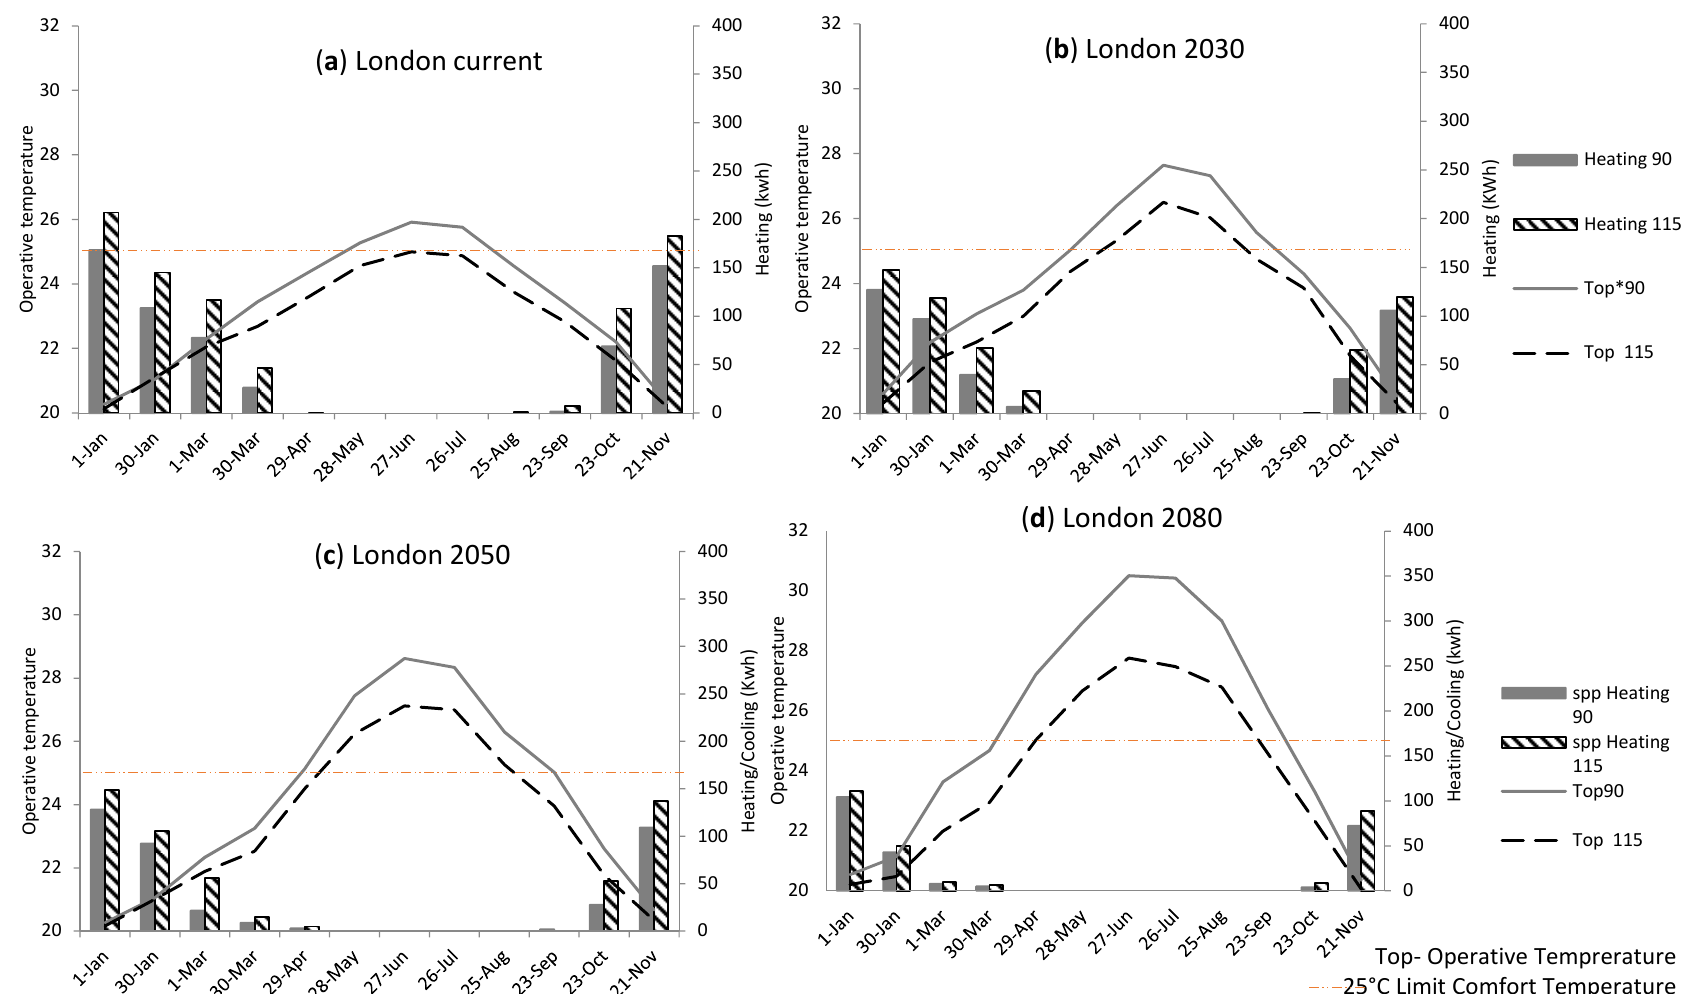
Figure 8. Indoor temperature and monthly supplementary heating required for the unit with vertical and tilt facade under four climatic